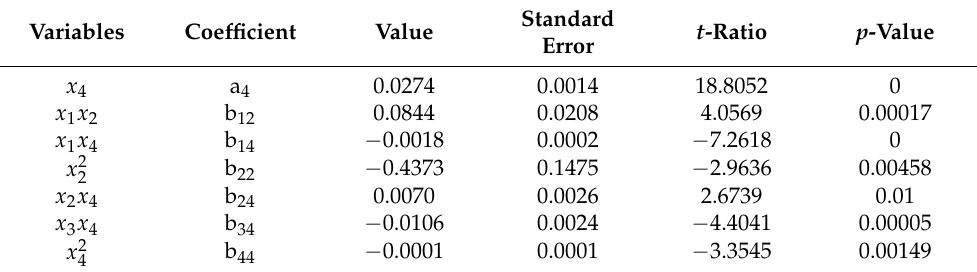
Table 4. Summary of the regression coefficients for h 0 − 95